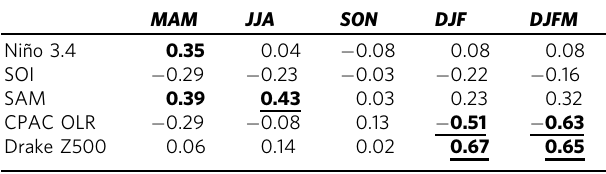
Table 1 Larsen C surface melt seasonal relationships with regional and large-scale climate